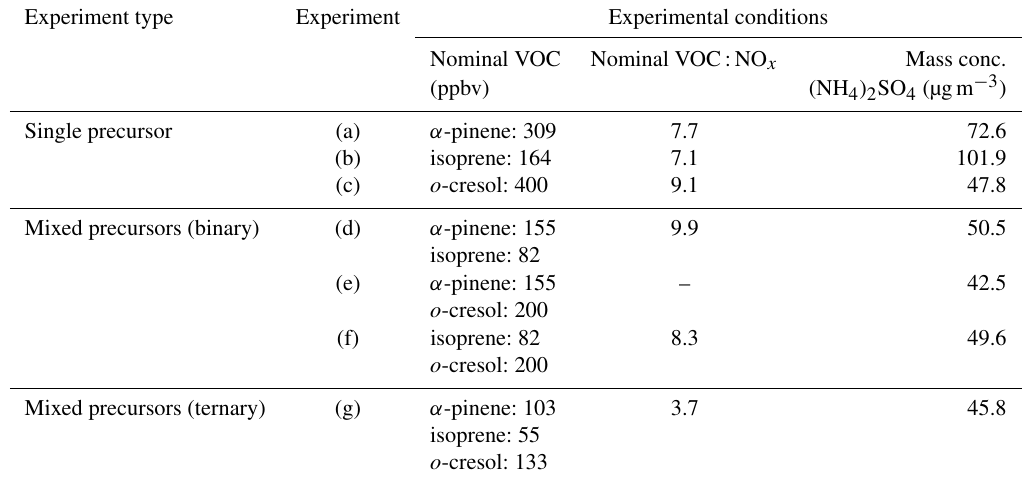
Table 1. Experimental descriptions, VOC mixing ratios, VOC:NOx ratio, and mass concentration of seed particles in the chamber. Experiment